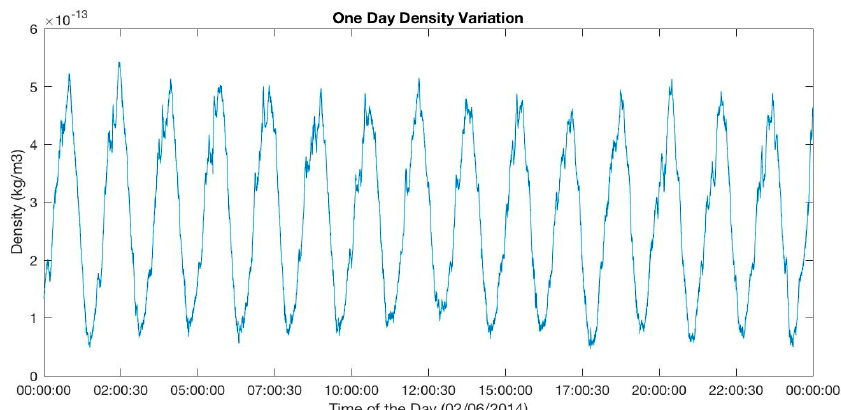
Figure 1. Diurnal density variation on 2nd June 2014. The unit of density is kg/m 3 . Time format is shown as HH:SS:MM.